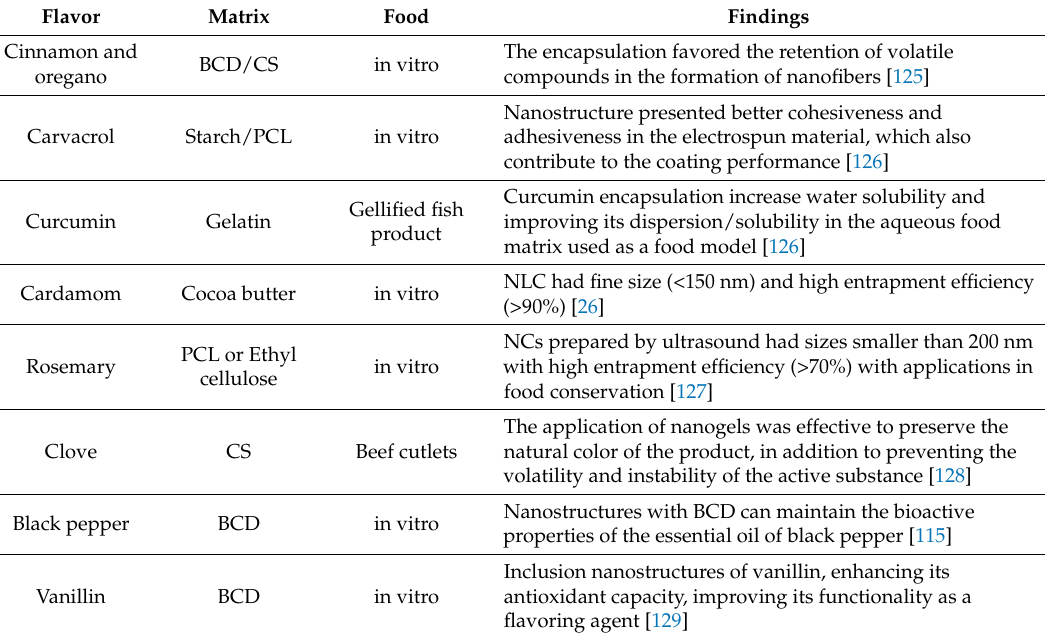
Table 5. Recent studies of nanostructured matrix containing flavors for food